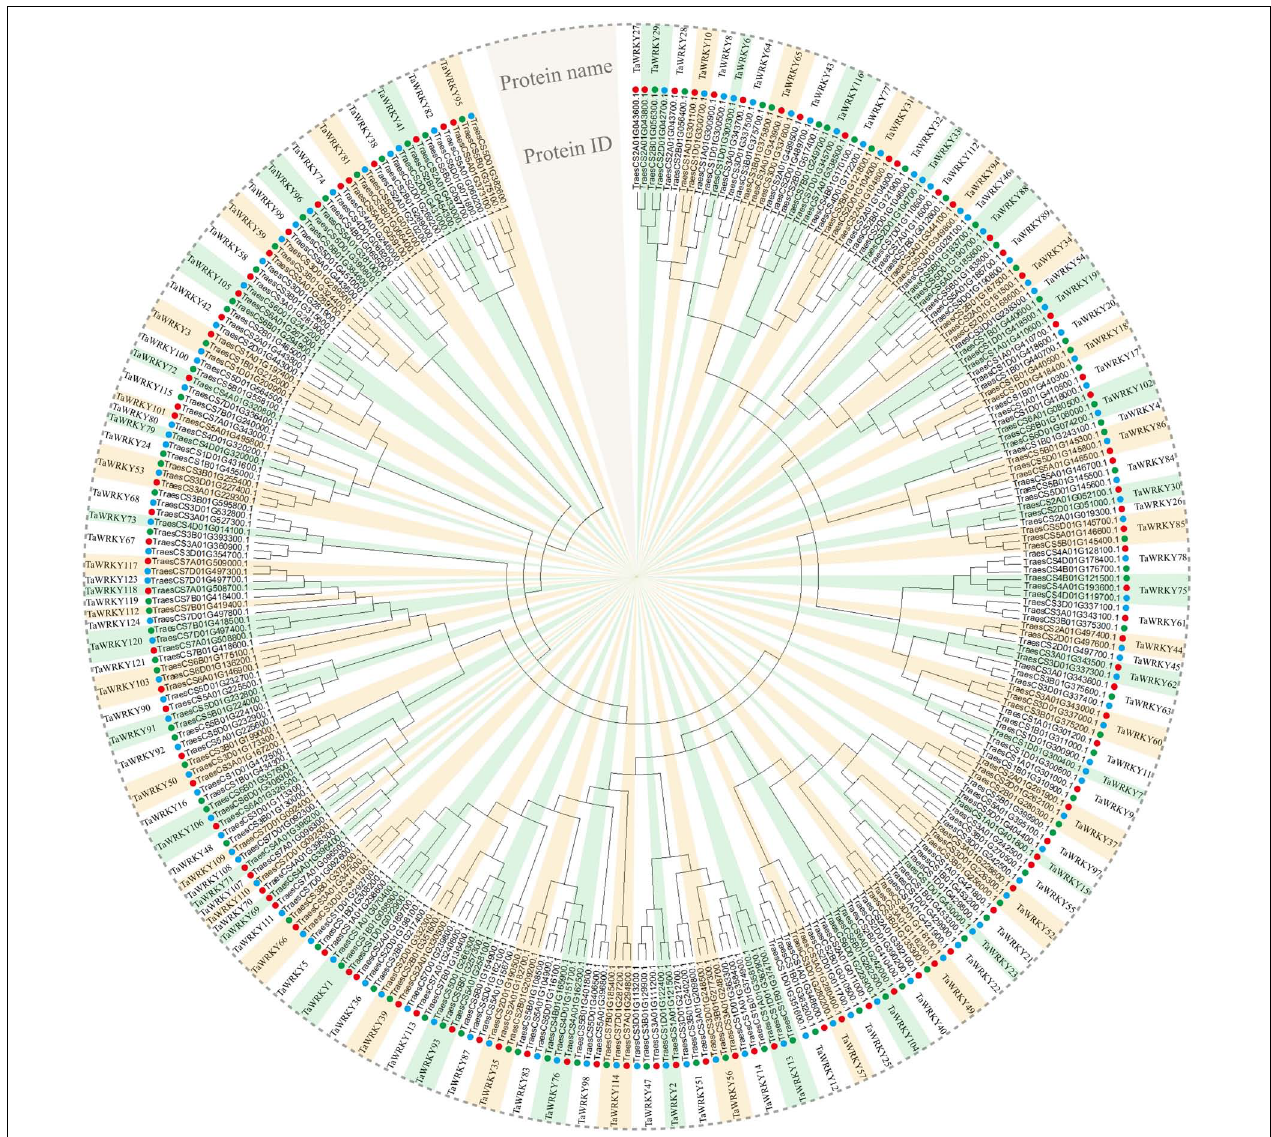
FIGURE 1 | Phylogenetic analysis of 294 TaWRKY homeologous copies. An unrooted phylogenetic tree divides these homeologous copies into 124 TaWRKY genes. The neighbor-joining method is performed in MEGA 6.0 software. The protein ID in the International Wheat Genome Sequencing Consortium database and the protein name of each TaWRKY gene are shown. Red, green, and blue dots indicate TaWRKY homeologous copies from subgenome A, B, and D,